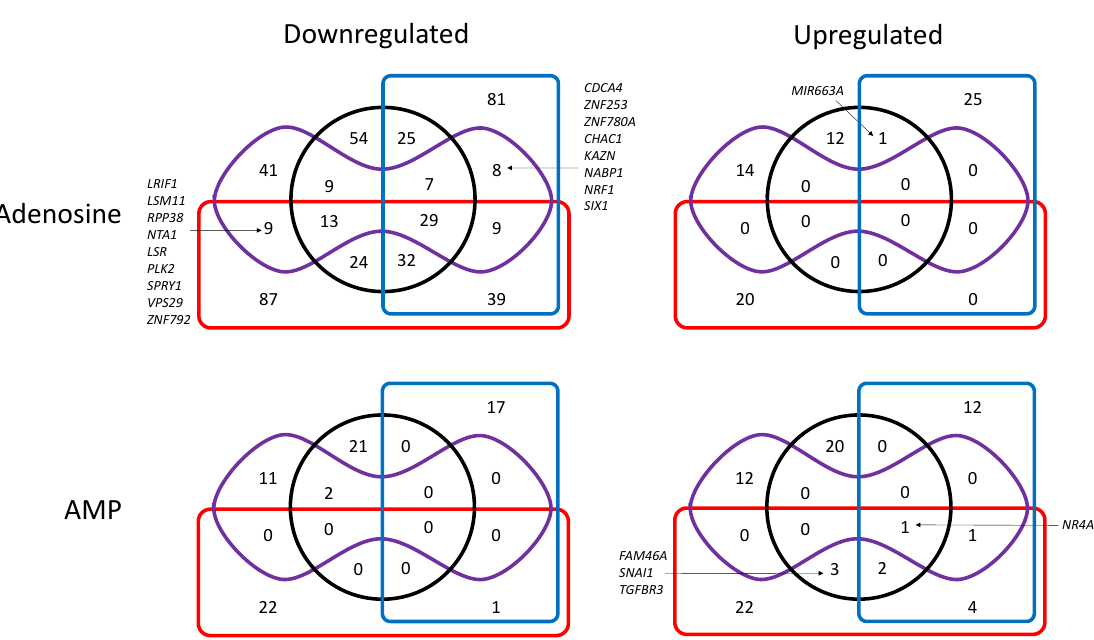
Figure 4. Venn diagram showing the number of at least 5-fold down- ( left) or upregulated ( right ) transcripts ( p < 0.05) in cells exposed to adenosine (upper panel) or AMP (lower panel) as compared to unexposed cells. Black circle: cN-II + /CD73 + ; red rectangle: cN-II − /CD73 + ; blue rectangle: cN-II + /CD73 − ; purple shape: cN-II − /CD73 − . When the number of transcripts is less than 10 in given groups, the names of transcripts are indicated. Complete list of transcripts is available in Supplemen- tary Tables S4 and S5.